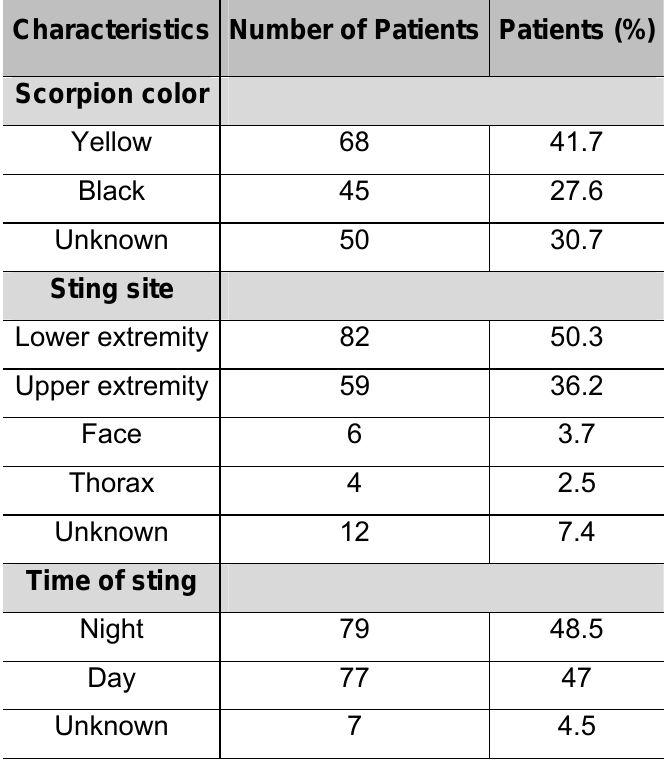
Table 2. Features of scorpion stings among the studied